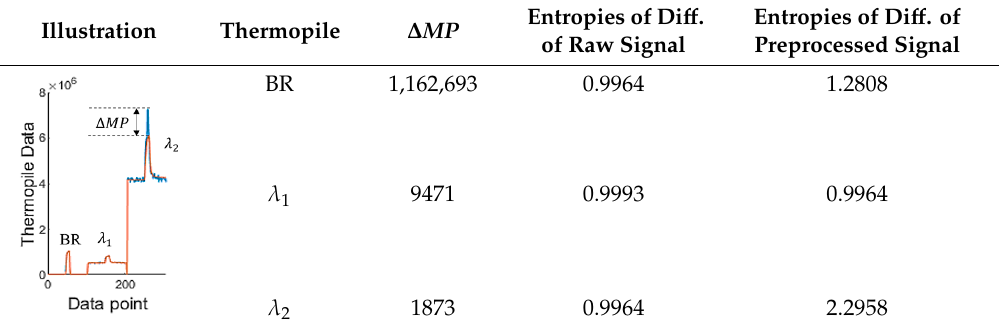
Table 1. The investigation of the raw and preprocessed signals.